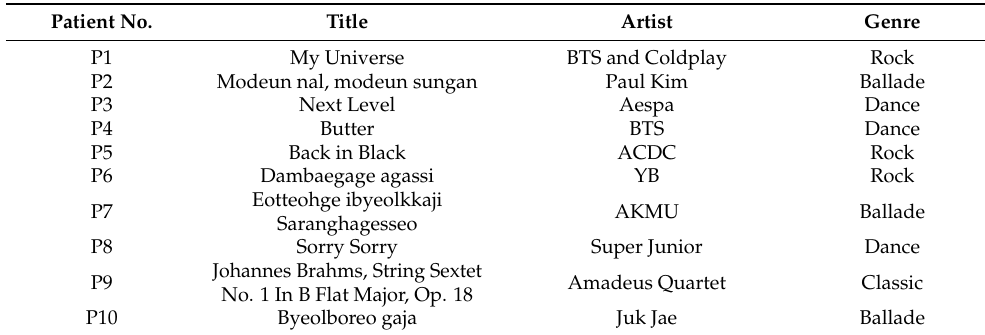
Table A1. Patient (cid:48) s music selection list. Patient